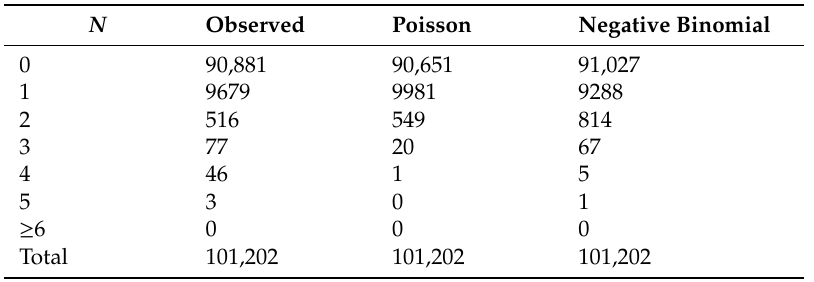
Table 3. Fitting the claims number with Poisson and negative binomial distribution.